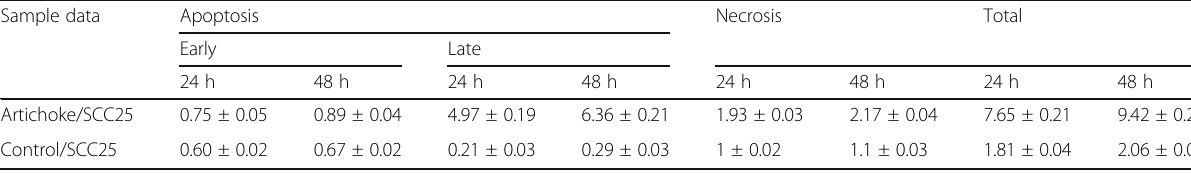
Table 4 Percentages of distinguished cell populations by annexin-V FITC flow cytometry analysis in both control- and artichoke- treated SCC-25 cell lines using paired Student ’ s t test and the results were represented as mean ±